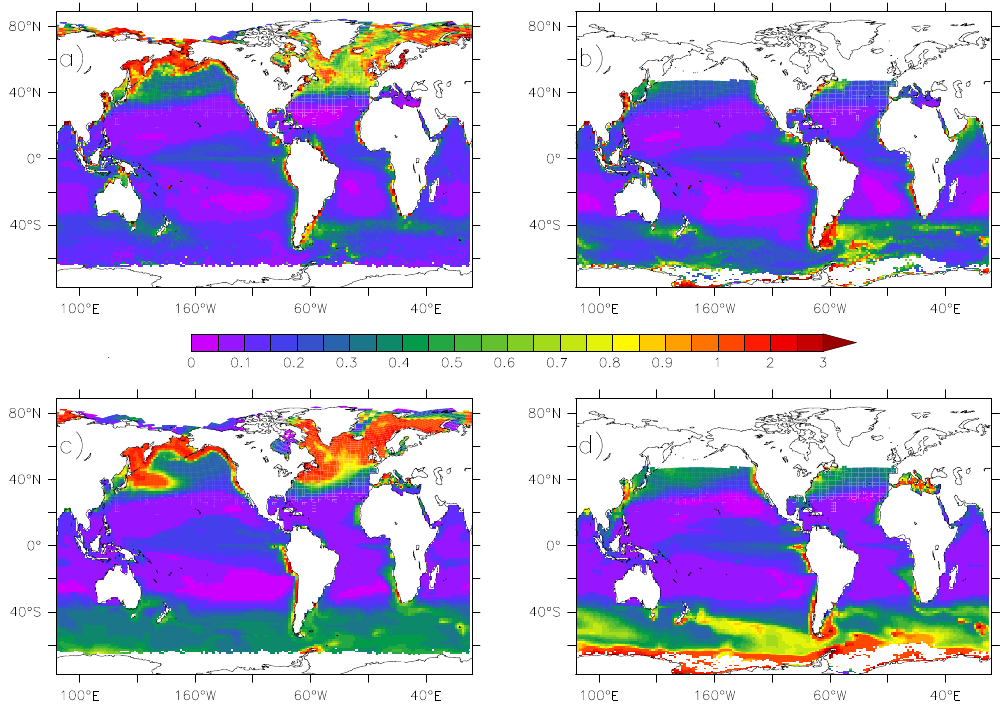
Figure 7. Surface seasonal mean chlorophyll concentrations (mgchl a m − 3 ) in April-May-June (panels a and c ) and November-December- January (panels b and d ). Panels (a) and (b) display satellite observations from GLOBCOLOUR. Panels (c) and (d) are model